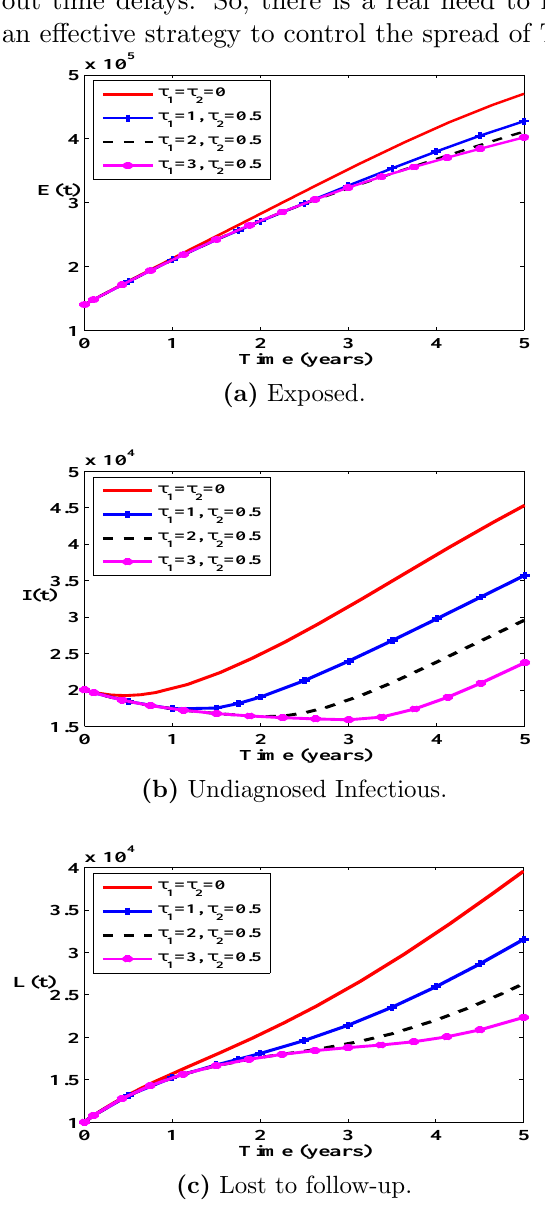
Figure 2. Number of E , I and L in- dividuals when v 1 = v 2 = v 3 = 0 , τ 2 = 0 . 5 year and time delay τ 1 takes different